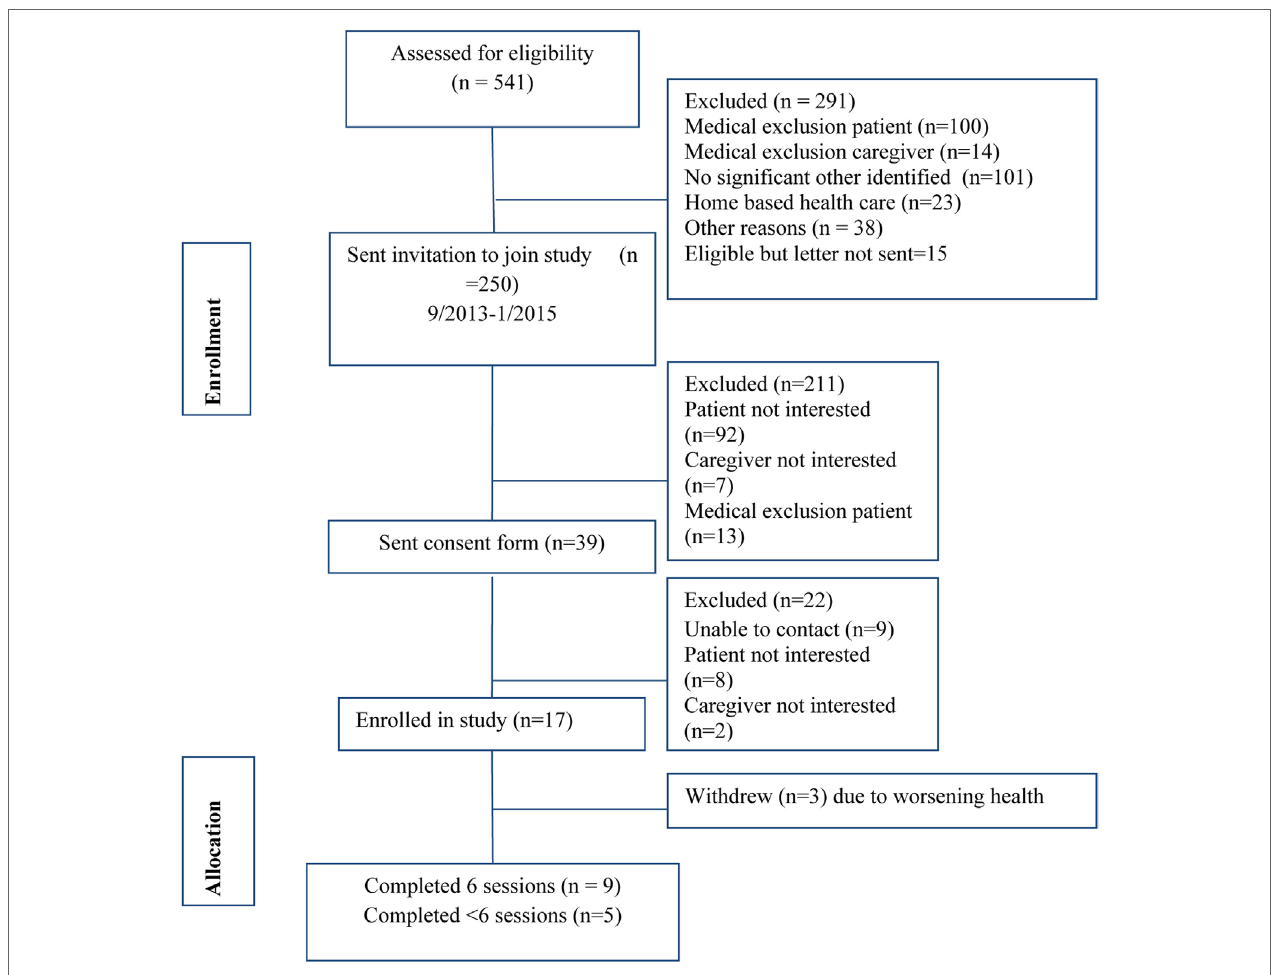
FigUre 2 | recruitment diagram